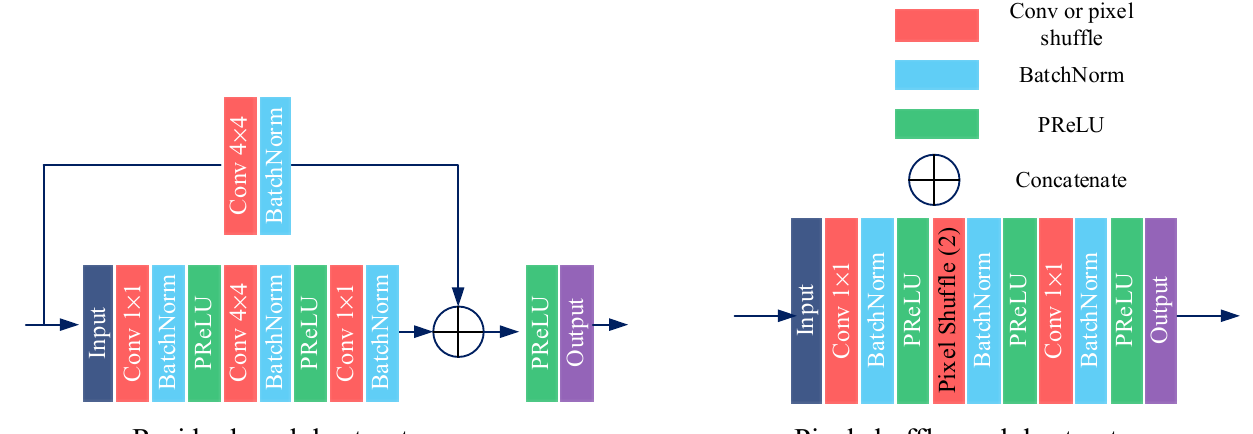
Figure 3. Proposed generator network.